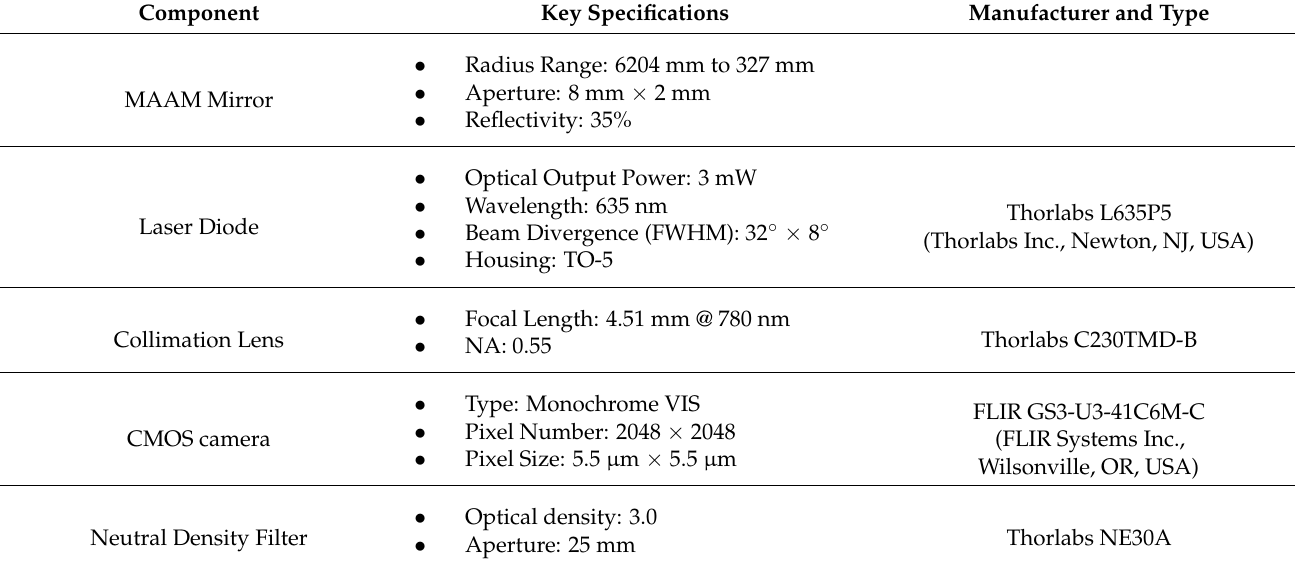
Table 3. Key specifications of the optical components in the characterization setup.